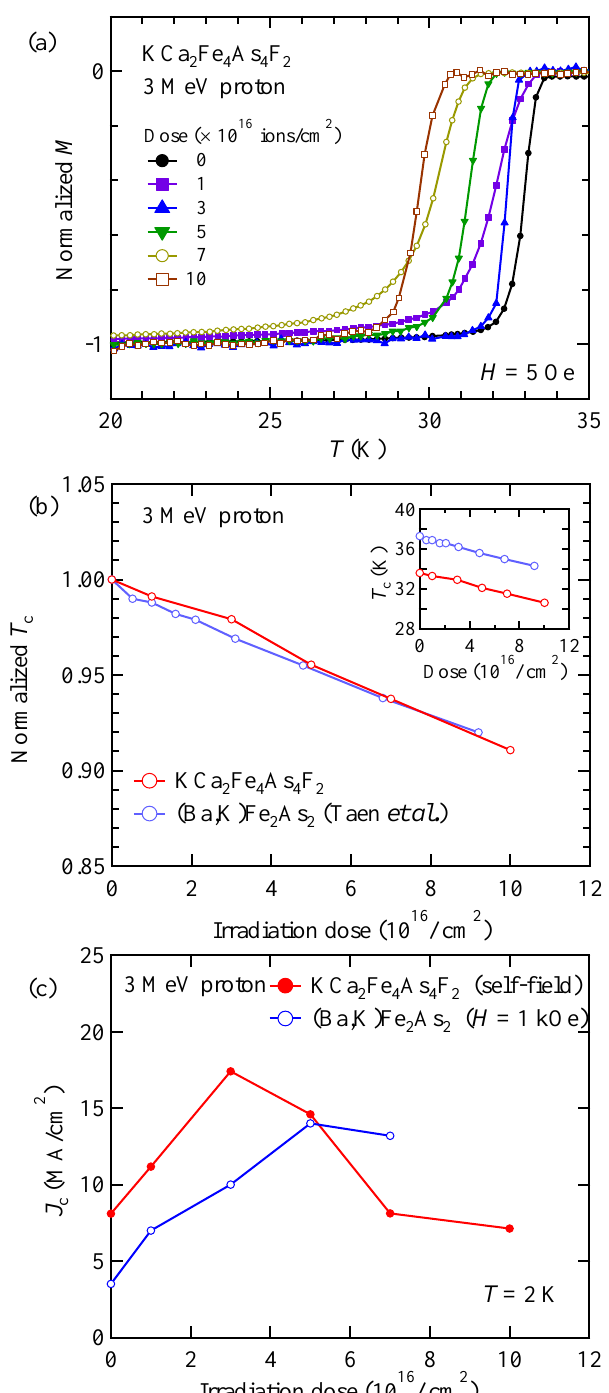
Figure 3. ( a ) Temperature dependence of normalized magnetization of 3 MeV proton irradiated KCa 2 Fe 4 As 4 F 2 with various dose at 5 Oe. ( b ) Dose dependence of normalized T c in 3 MeV proton irradiated KCa 2 Fe 4 As 4 F 2 and (Ba,K)Fe 2 As 2 [27]. Dose dependence of T c is also shown in the inset of ( b ). ( c ) Dose dependence of J c at 2 K in 3 MeV proton irradiated KCa 2 Fe 4 As 4 F 2 at self-field and (Ba,K)Fe 2 As 2 at H = 1 kOe.